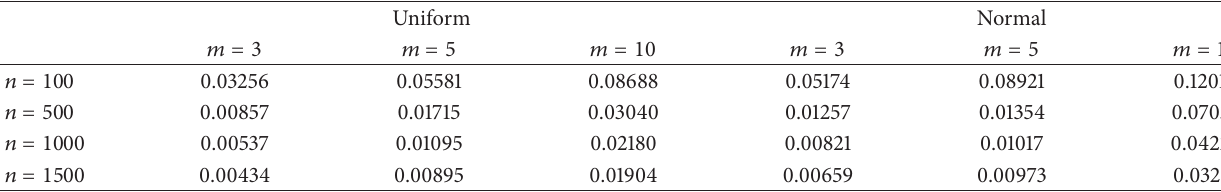
Table 1: Convergence results of the SPTA-F rule.